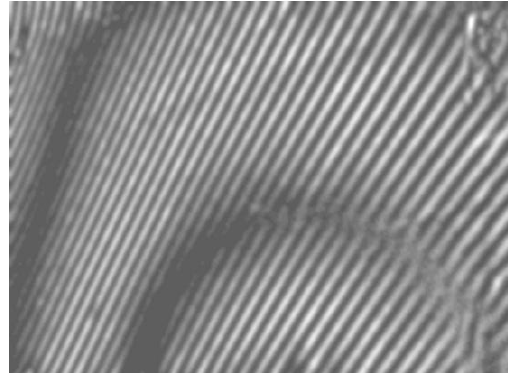
Figure 13. Result of the double-exposure whole-field projection